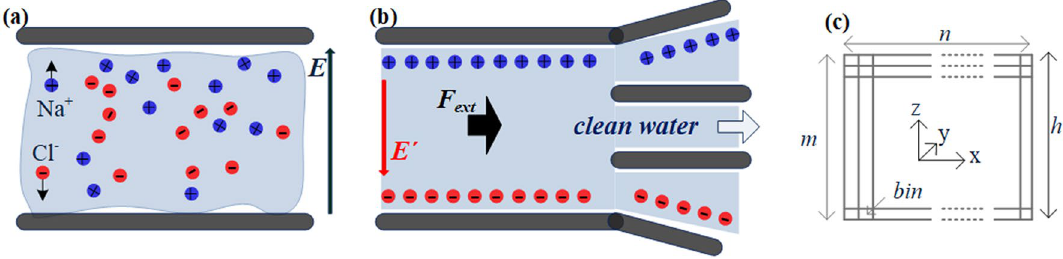
Figure 1. Ion/water flow between two solid walls, channel model (periodic in x- and y- dimensions, while, h , is the channel height, in the range 3 nm ≤ h ≤ 62 nm ). Blue and red circles are Na + and Cl − ions, respectively . The external electric field E z is applied perpendicular to the flow (driven by the external force F x ). Here is the channel: ( a ) in the beginning of the simulation, ( b ) after the application of E , where an internal E´ is created, while F x drives the flow, ( c ) the division in computational bins m × n × k ( k is in the y